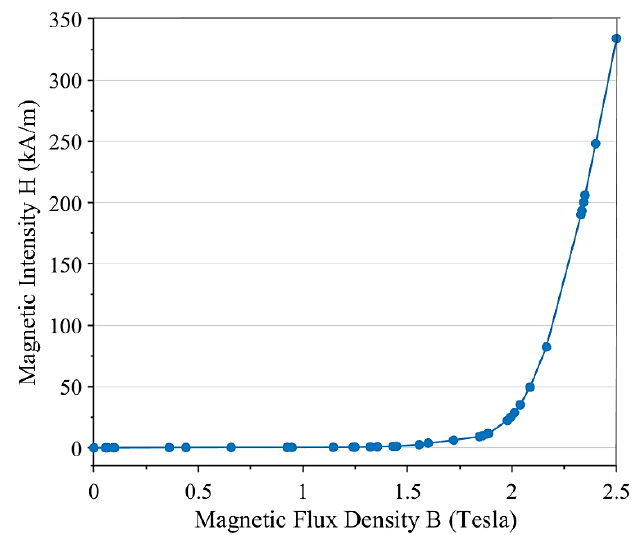
Figure 6. The B–H curve of 1008 steel.